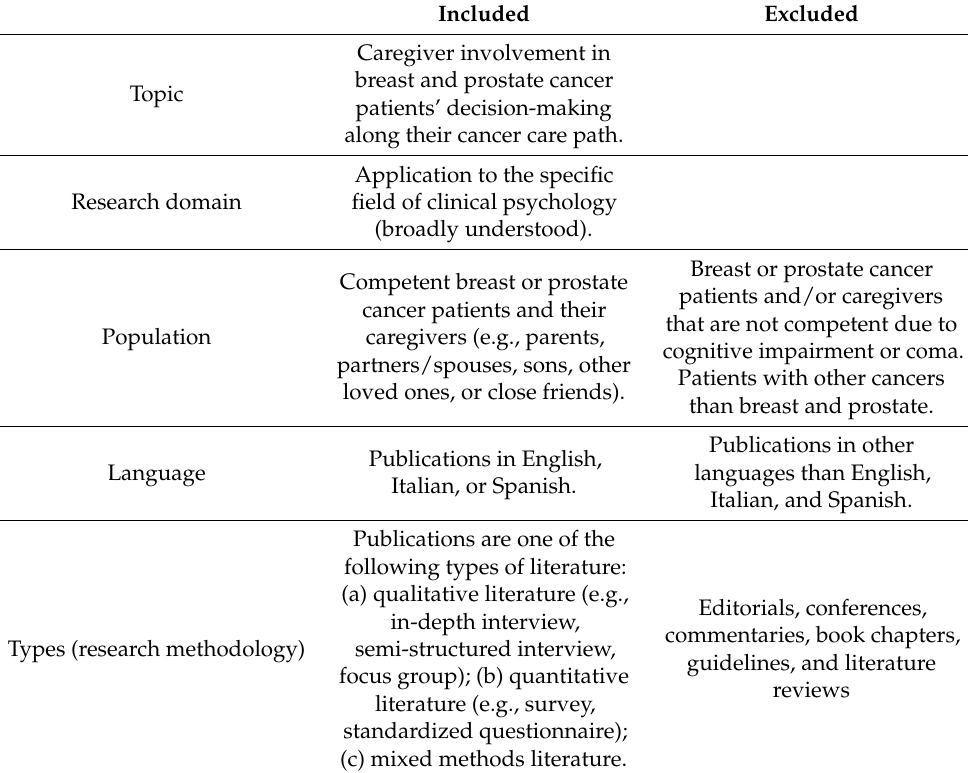
Table 1. Eligibility Criteria (with exclusion criteria). Included Excluded Caregiver involvement in breast and prostate cancer Topic patients’ decision-making along their cancer care